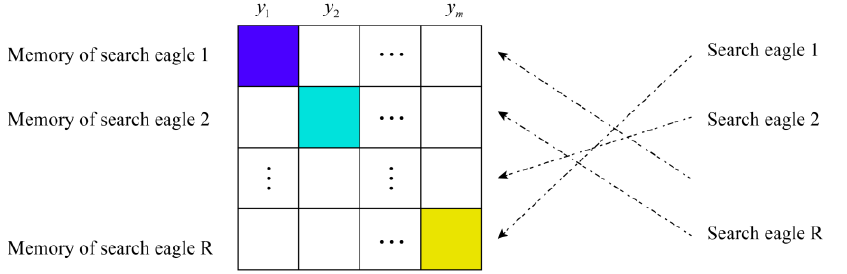
Figure 3. Prey selection in the GEO algorithm.